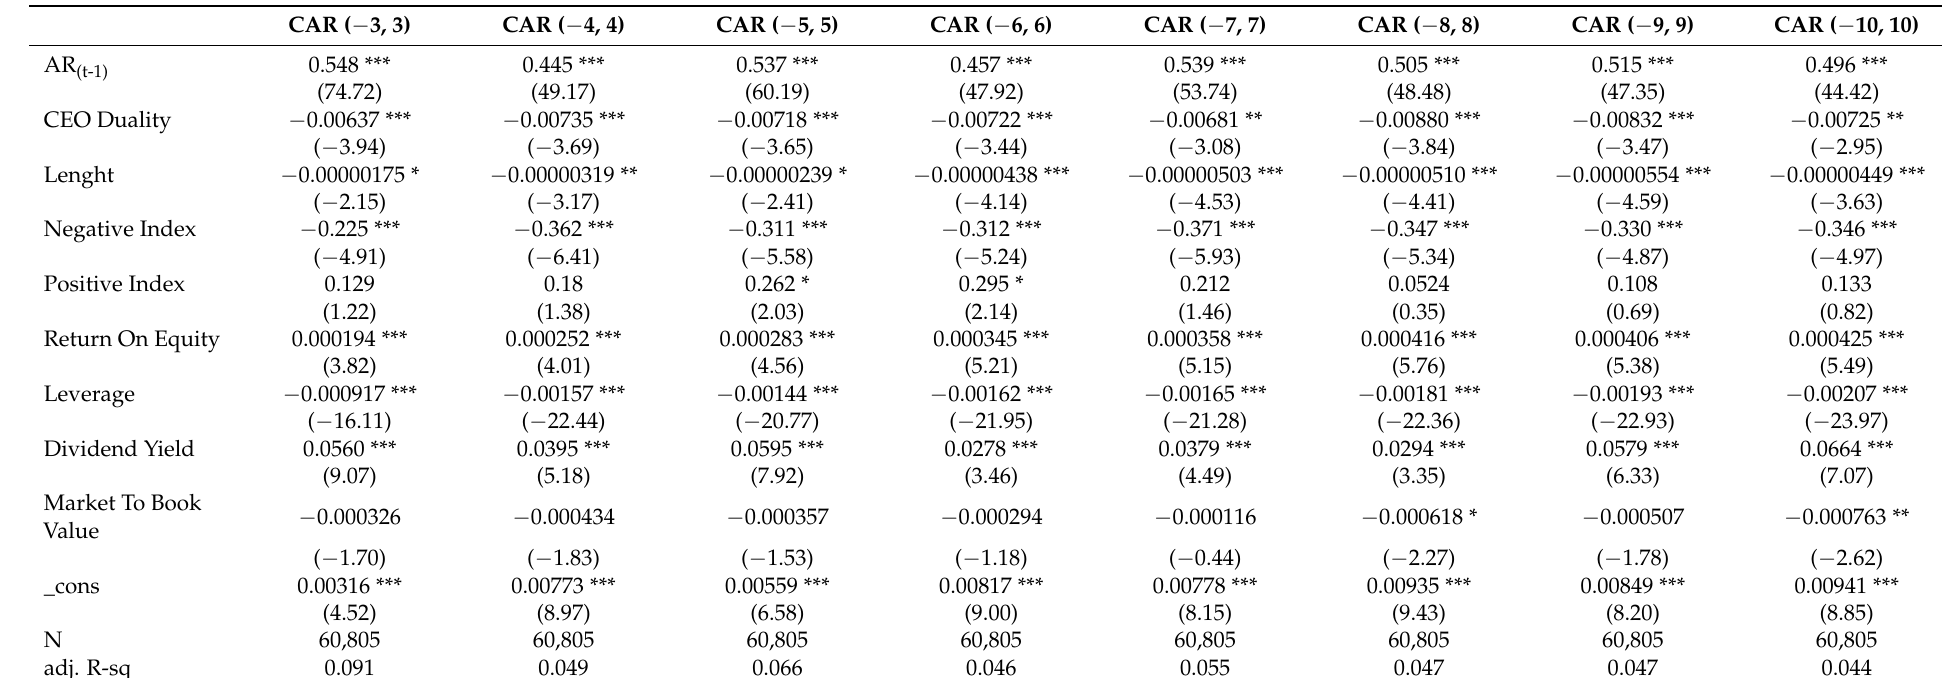
Table 10. Robustness test. CEO duality, sentiment and stock market reaction over longer